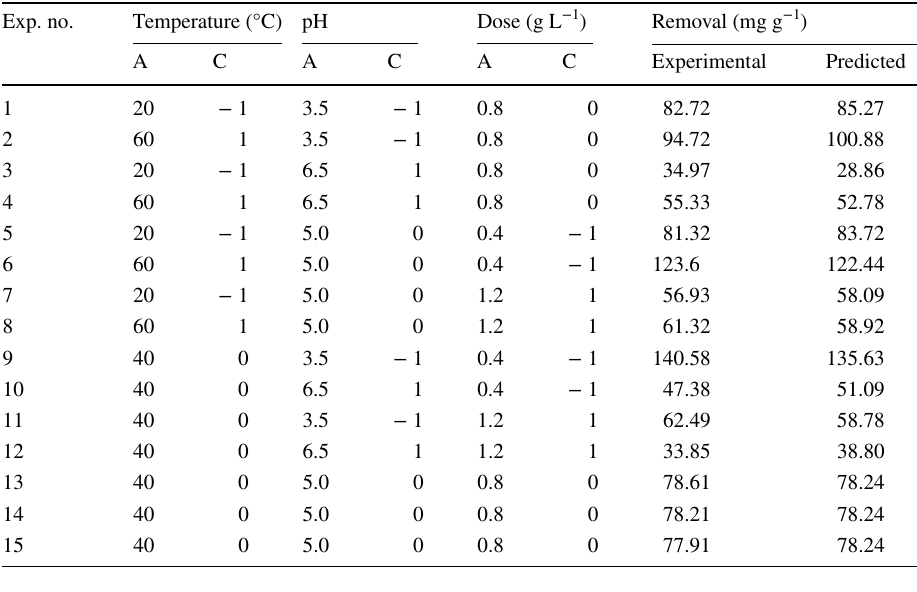
Table 3 ANOVA of the response surface quadratic model for the prediction of aqueous PO 43− removal by AC/ NZVI